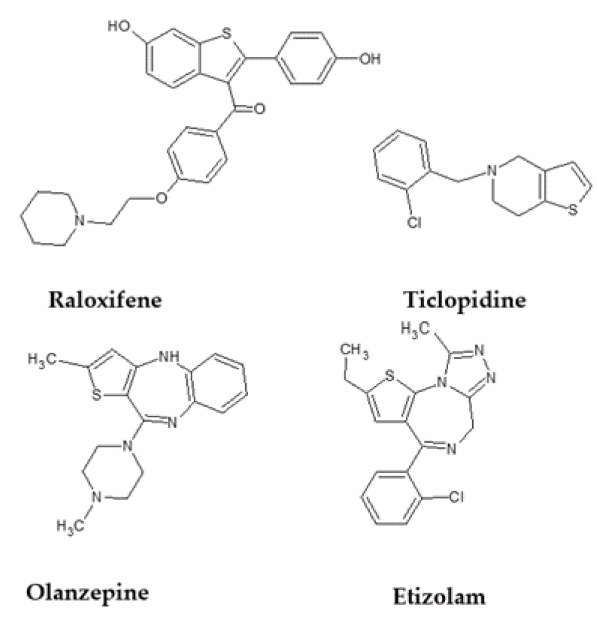
Figure 1. Thiophene-heterocycles-fused compounds known in